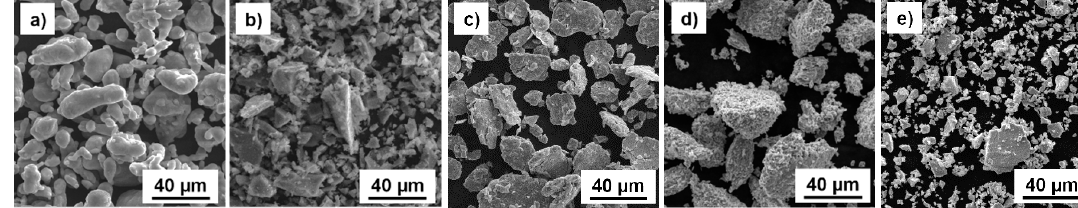
Figure 8. Morphology of: ( a ) Al; ( b ) Si; ( c ) Fe; ( d ) Cr; and ( e ) Mn powders used for short-term MA.